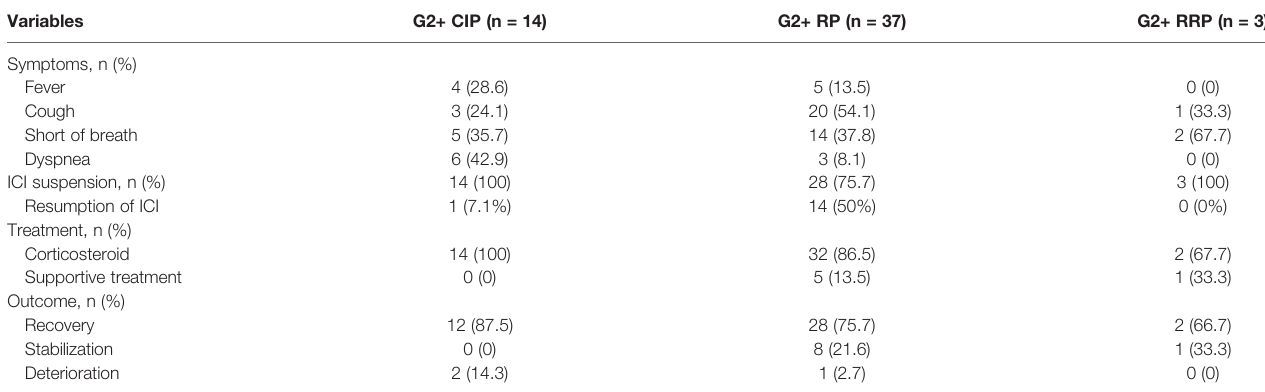
TABLE 3 | Characteristics of symptomatic pneumonitis.